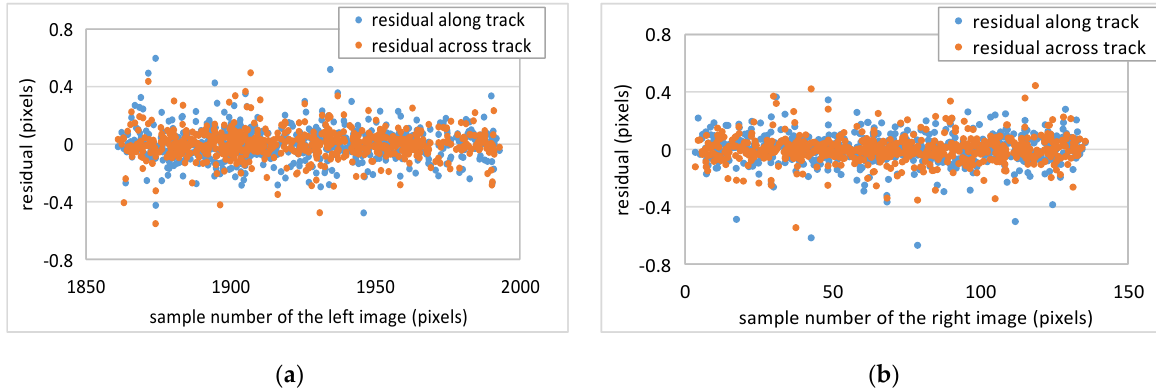
Figure 8. Relative orientation residual (without data error): ( a ) Residual of left-middle images; ( b ) Residual of right-middle images.